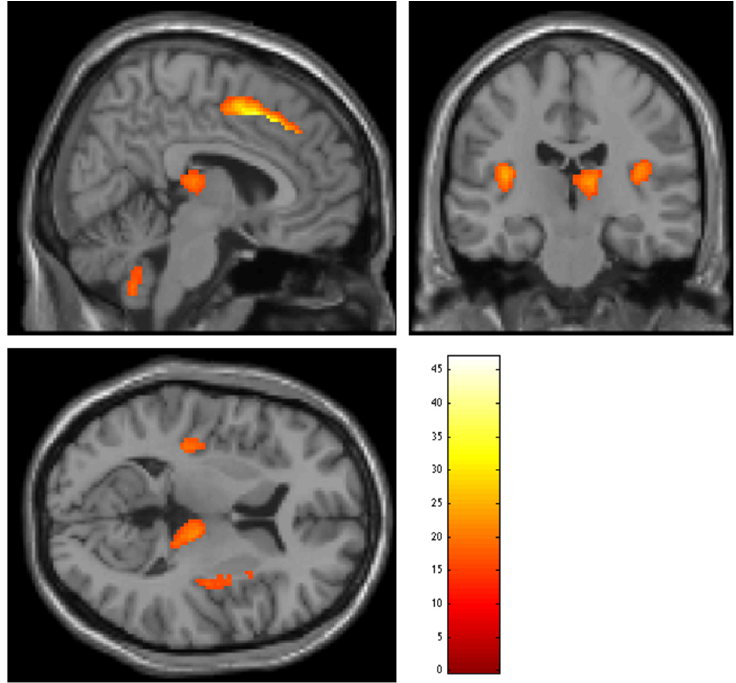
Fig 2. Regions of increased grey matter volume from baseline to follow-up in patients with